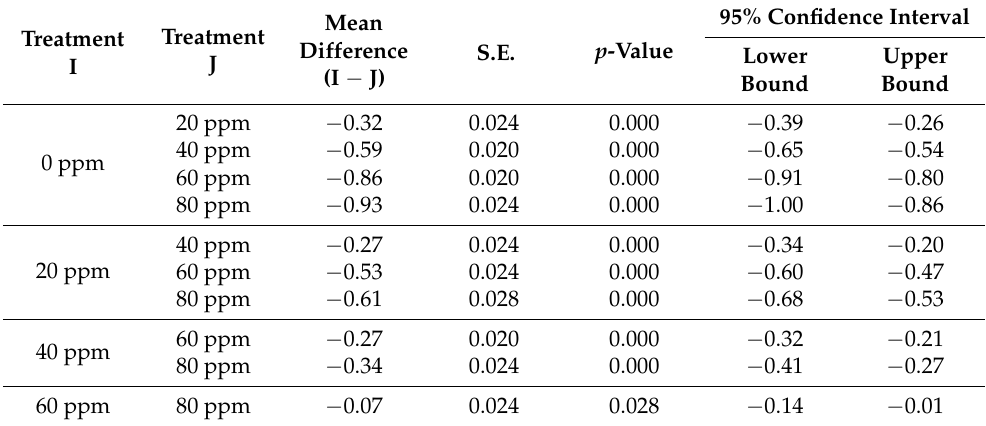
Table 2. Partial comparisons of mortality rates between the control and the four treatment groups (20, 40, 60, and 80 ppm